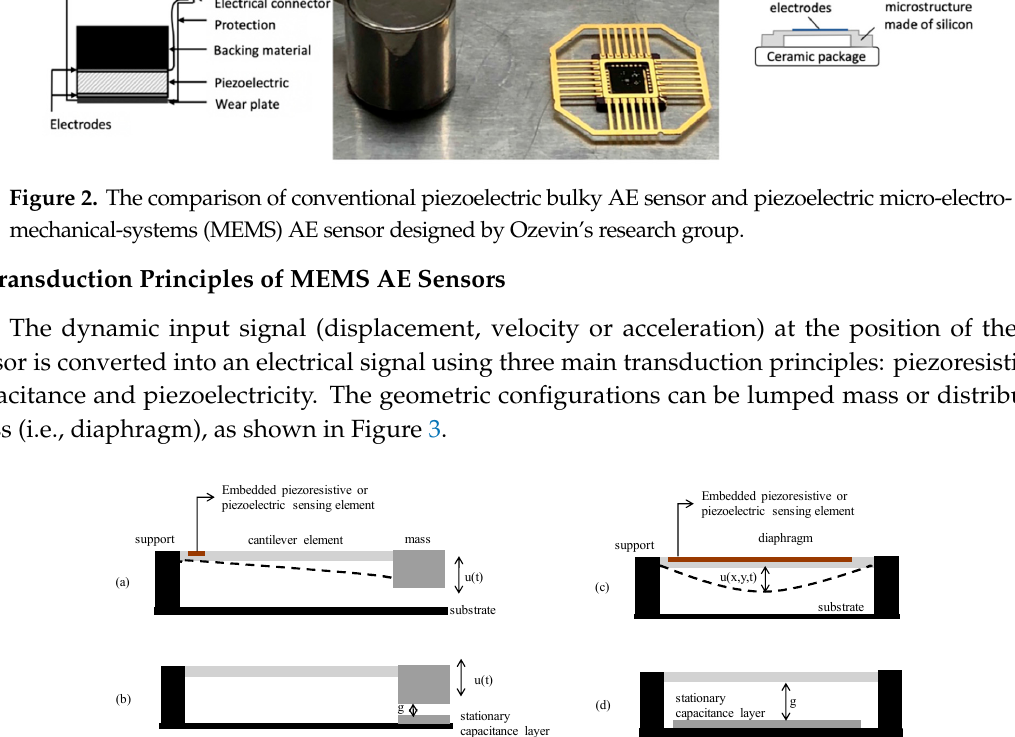
Figure 3. Different geometries and sensing configurations, ( a ) lumped mass + cantilever beam with piezoelectric or piezoresistive element, ( b ) lumped mass + cantilever beam with capacitive sensing, ( c ) distributed mass on a diaphragm with piezoelectric or piezoresistive element, ( d ) distributed mass on a diaphragm with capacitive sensing.